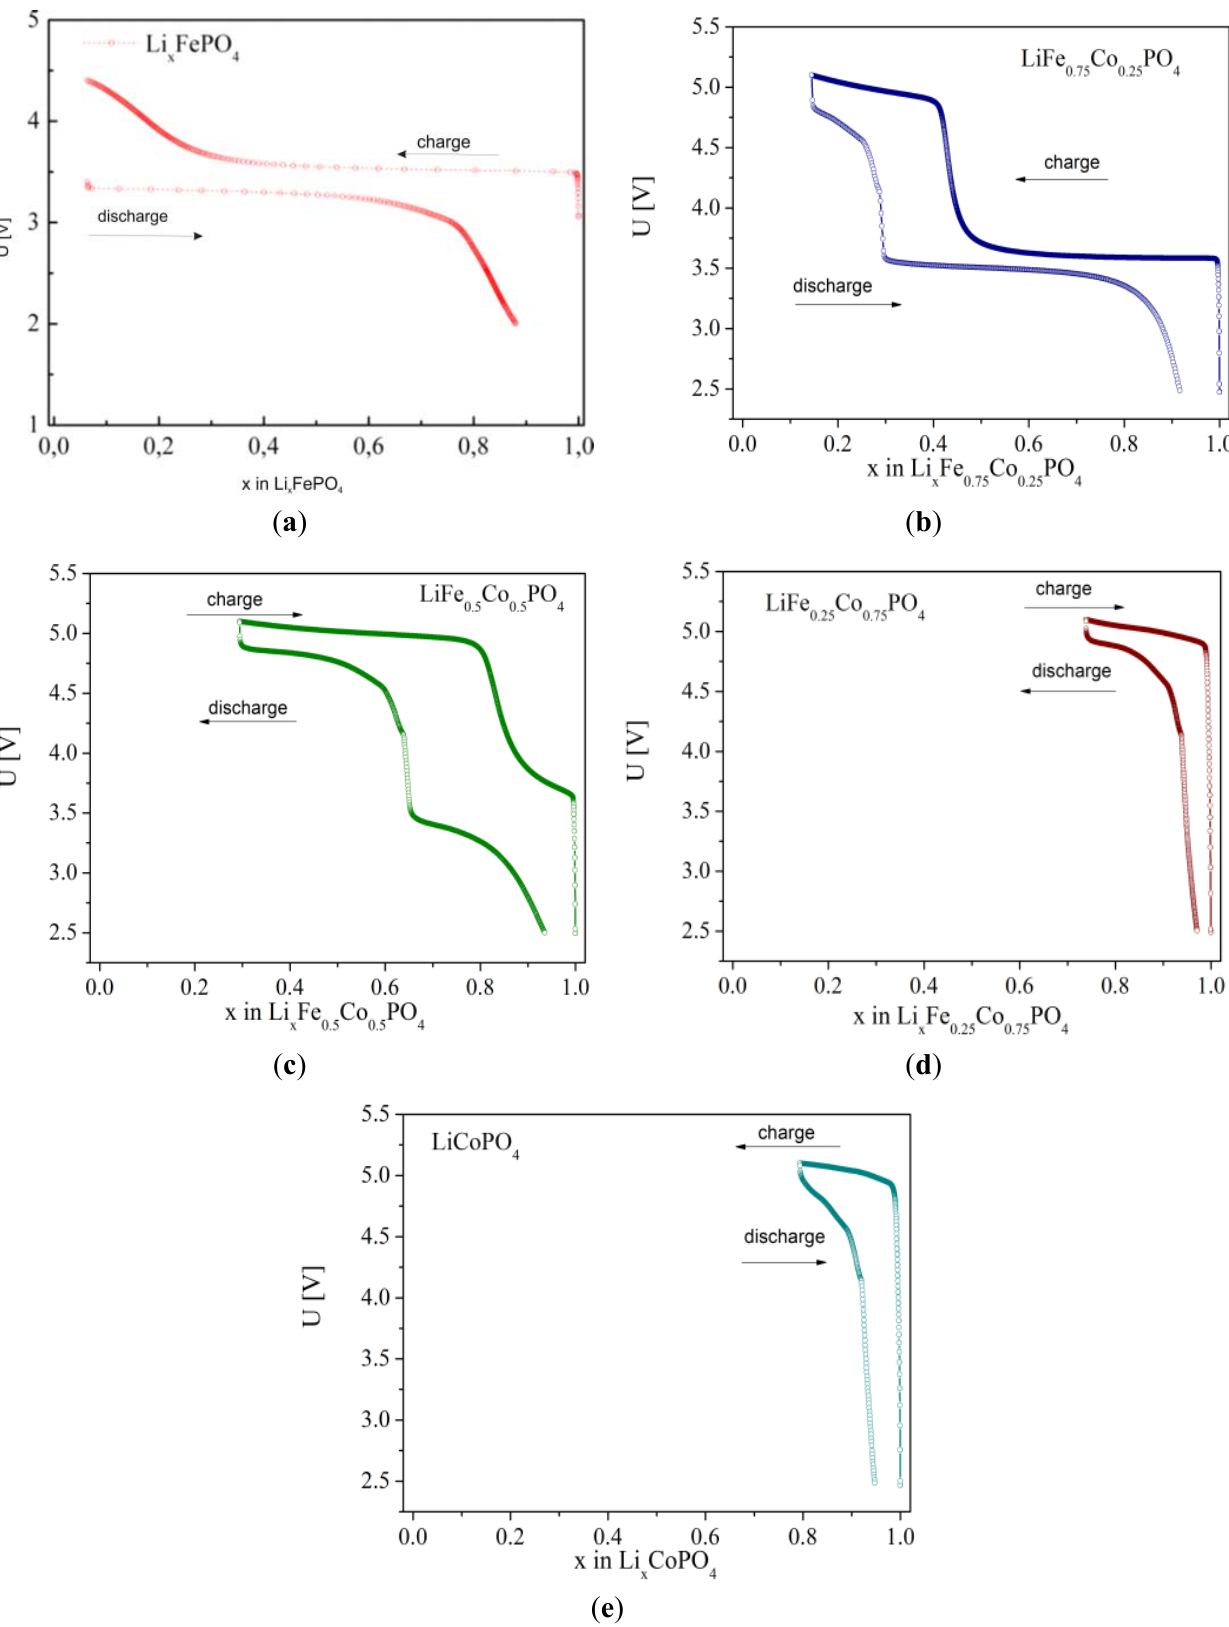
Fe Co PO cells recorded with C/10 x 1 − y y 4